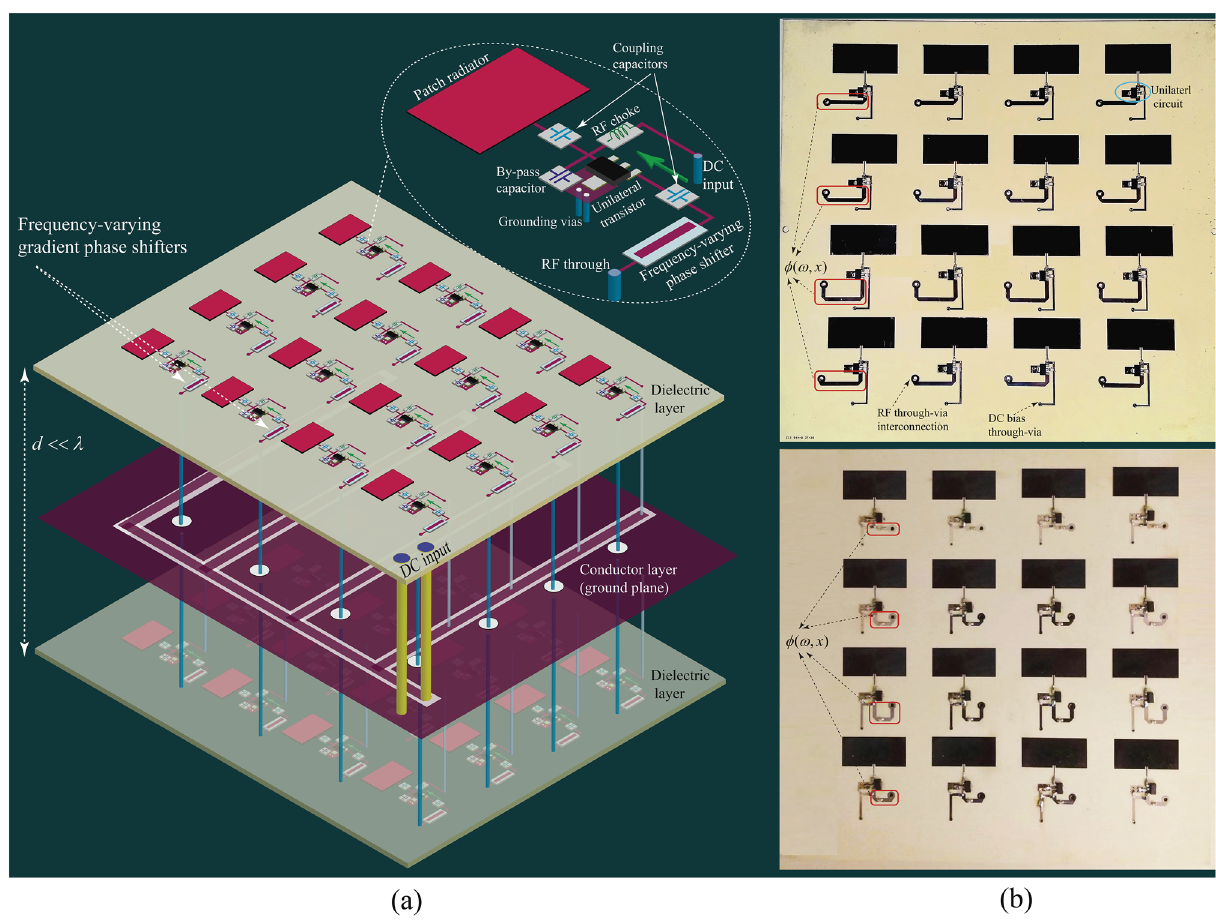
Figure 7. Nonreciprocal polychromatic metasurface. ( a ) An exploded-view of the architecture of the polychromatic transmissive metasurface. ( b ) Top and bottom layers of the fabricated metasurface.